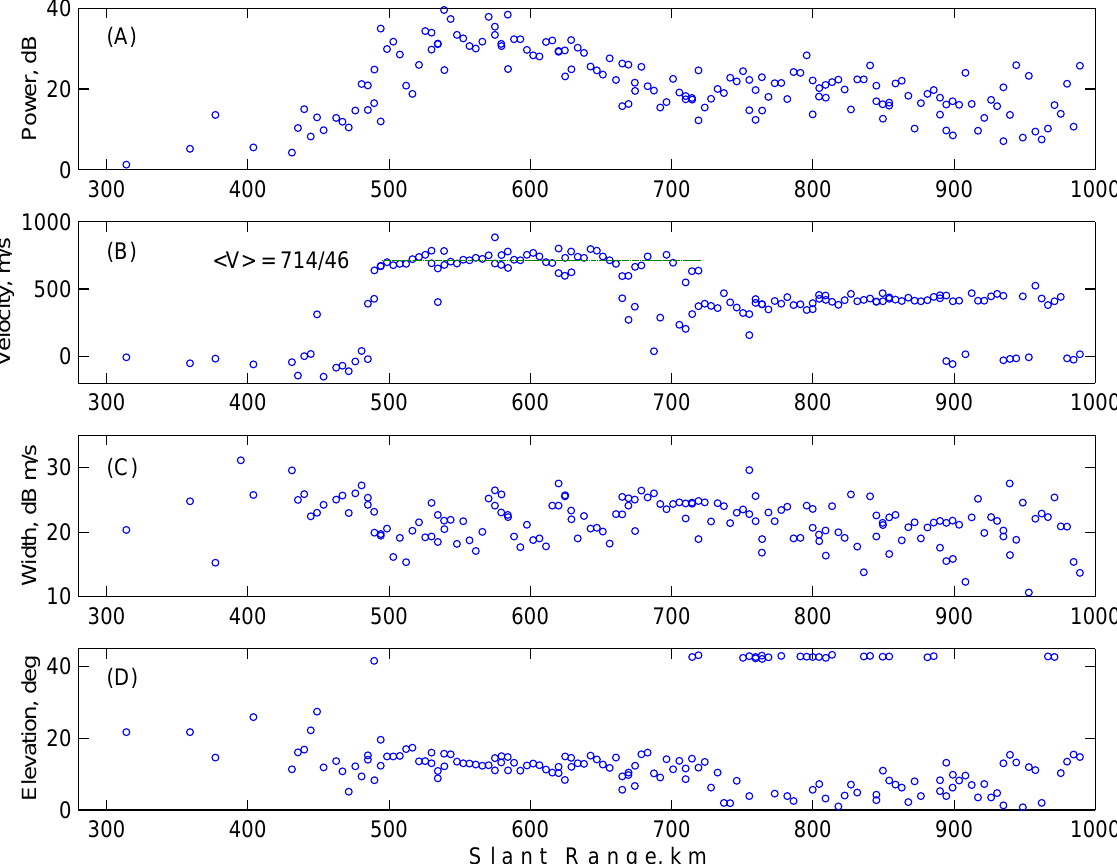
Fig. 6. Experimental slant-range profiles for (a) echo power, (b) Doppler velocity, (c) spectral width, and (d) elevation angle.